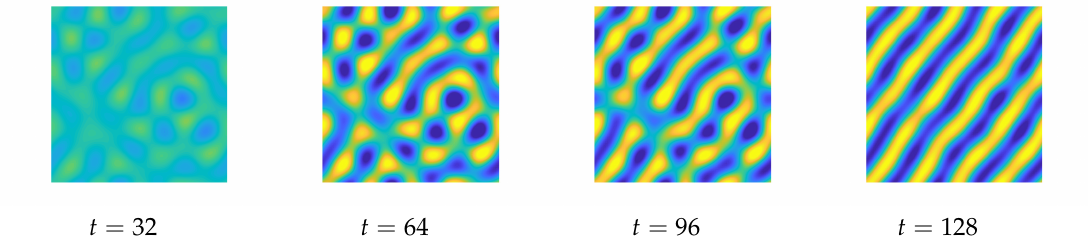
0.3420, respectively. −